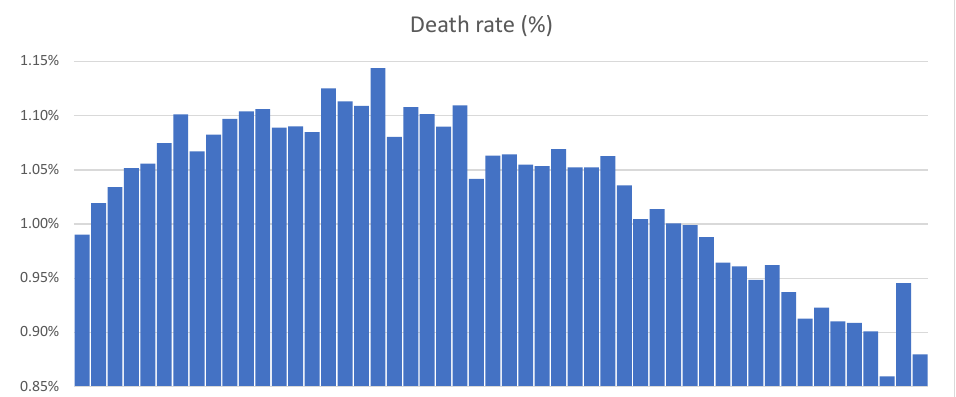
Figure 23. Mortality in Sweden: ( a ) daily mortality for 2015–2021; ( b ) number of death for 1970–2021; ( c ) death rate for 1970–2021. Source: Statistics